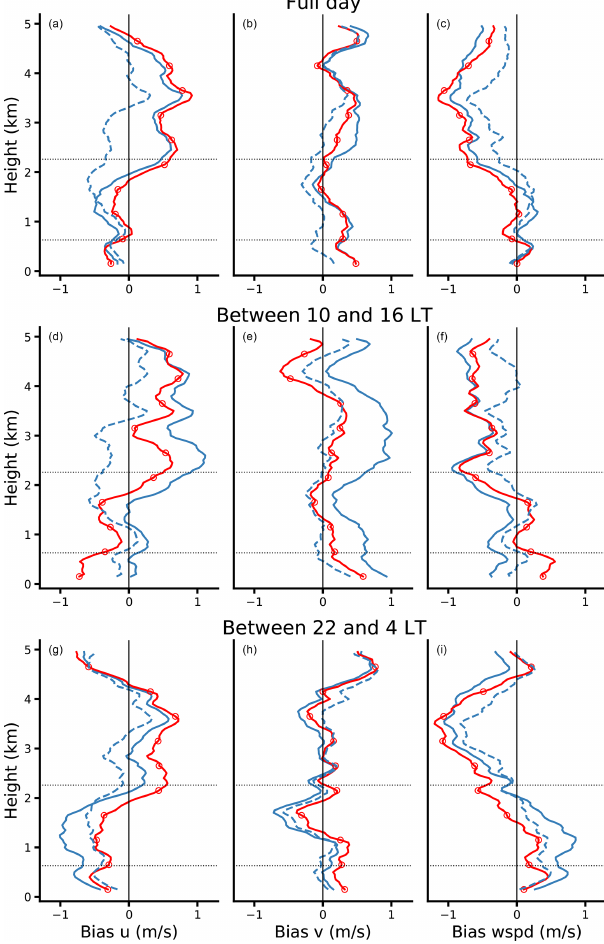
Figure 15. Mean model bias for ERA5 (dashed blue), the opera- tional forecast (solid blue), and a forecast with the new model cy- cle 47r3 (red circles). The bias is shown separately for all hours of the day (a–c) , for daytime between 10:00 and 16:00LT (d–f) , and for nighttime between 22:00 and 04:00LT (g–i) . The bias is cal- culated with respect to radiosondes. From left to right the columns refer to the bias in the zonal wind ( u ), meridional wind ( v ), and wind